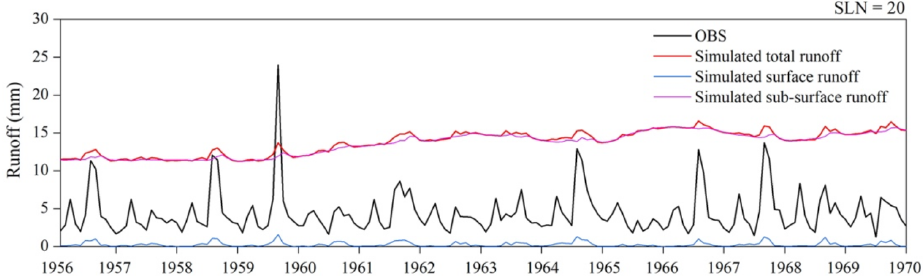
Figure 3. Observed and simulated total runoff, surface runoff, and subsurface runoff from 1956 to 1969 by the run with actual soil depths. The SLN was set to 20.